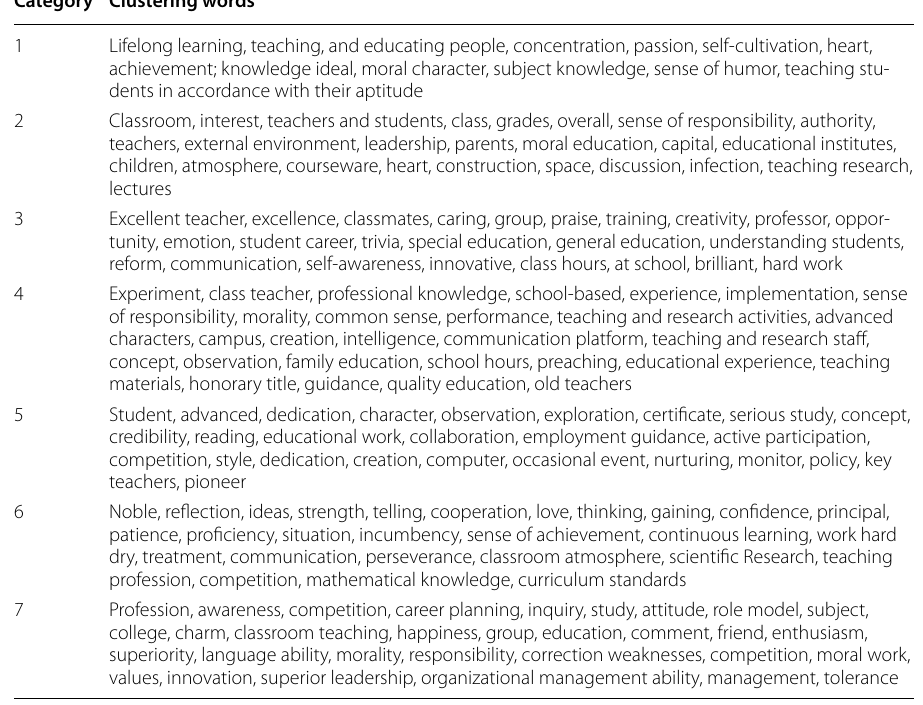
Table 6 Clustering results Category Clustering